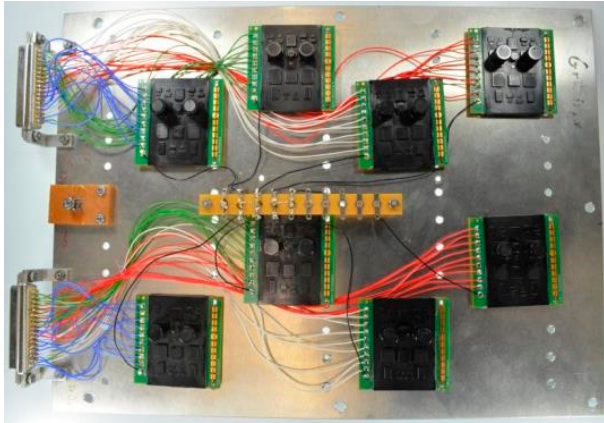
Figure 5. Eight encapsulated PCBs fixed on the mounting plate to be placed in the climatic chamber for the temperature shock tests.